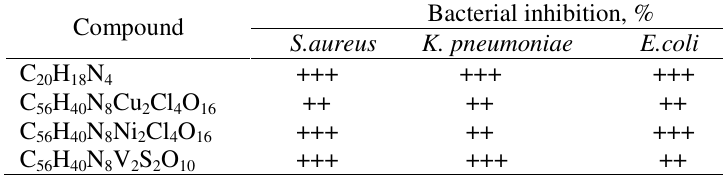
Table 1 . Antibacterial activity of the ligand and complexes